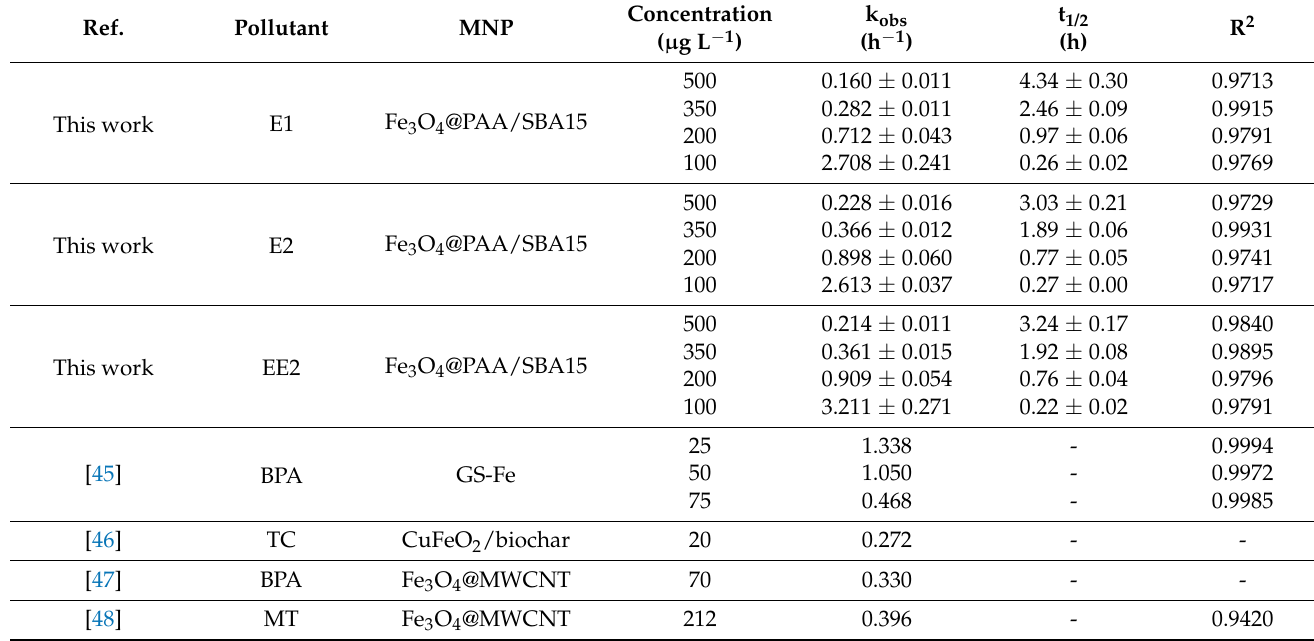
Table 2. Kinetic constants and half-life for Fe 3 O 4 @PAA/SBA15 degradation experiments performed in this study compared with other Fe-based nanocatalysts reported in the